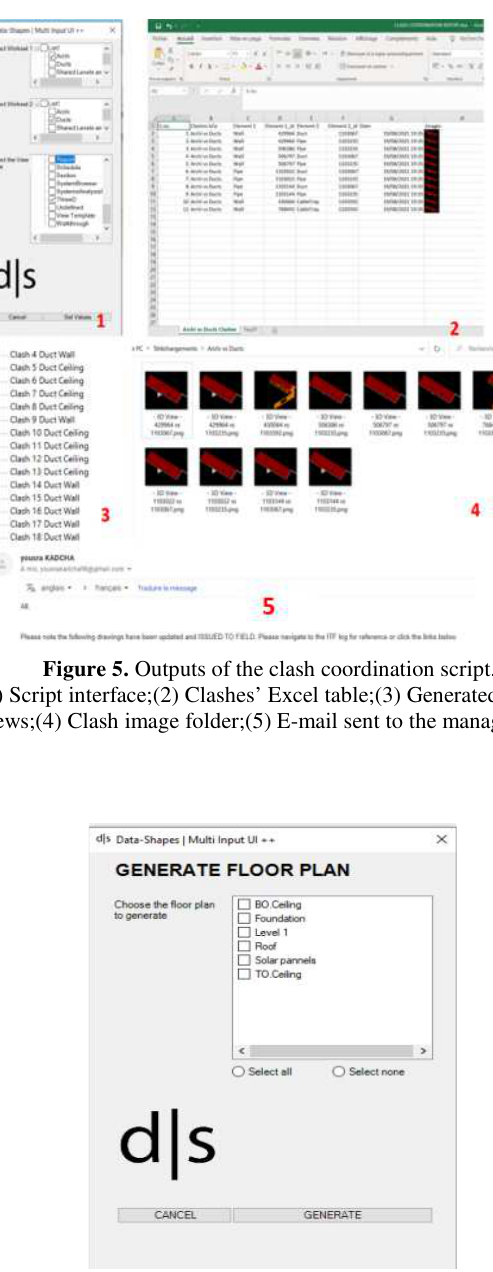
Figure 6. Plans extraction